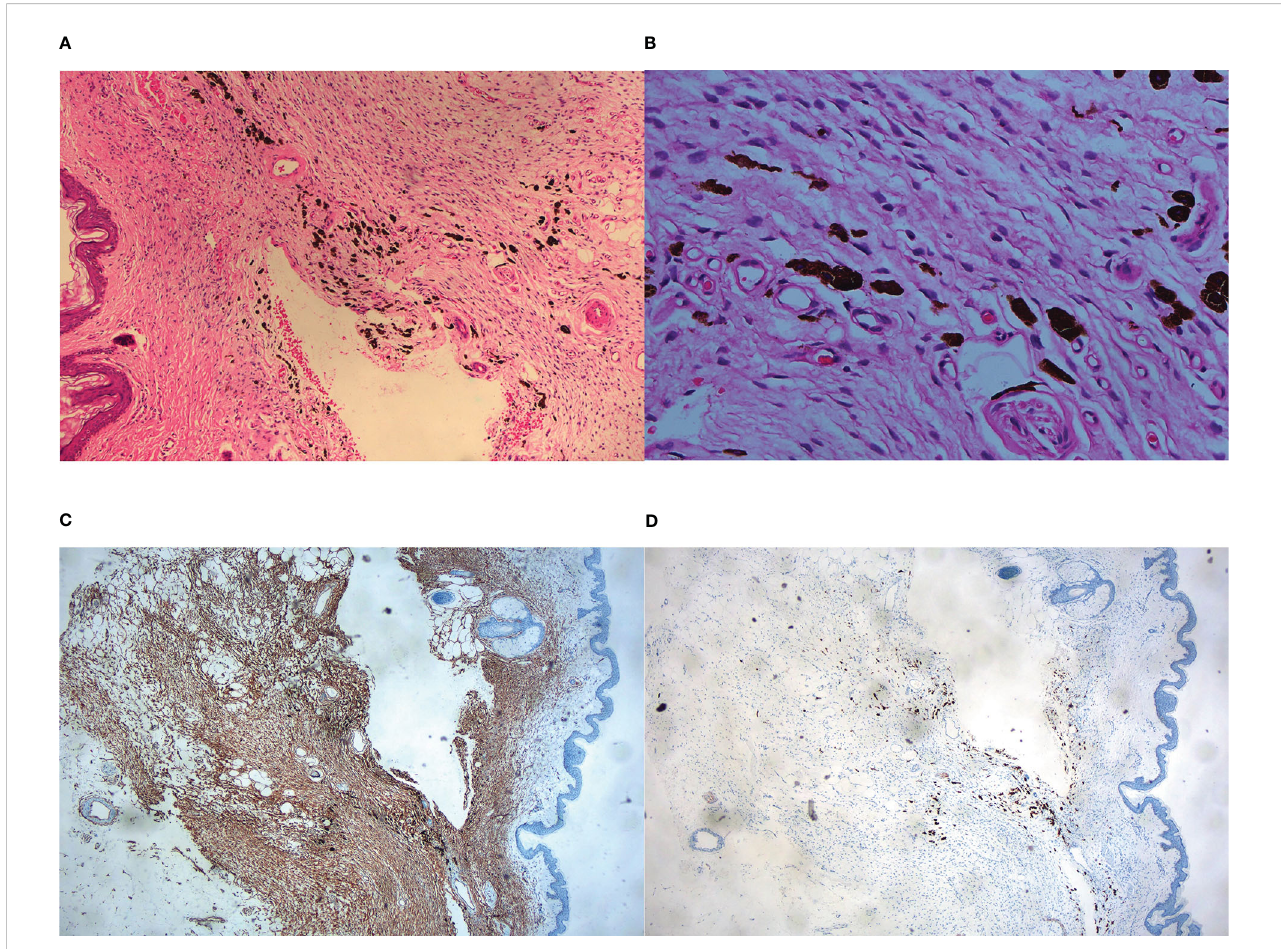
FIGURE 4 Histopathological examination. (A) Fascicles of spindle cells with reduced dermal thickness by about half on low-power view, HE ×40; (B) Monomorphic spindle cells with bland cytoplasm and scattered dendritic cells containing abundant melanin, HE ×200; (C) Immunohistochemistry showed CD34 + cells in fi ltrating into subcutis and forming honeycomb-like pattern, ×40; (D) Immunohistochemistry showed spindle cells were negative for S-100, in contrast, melanin-bearing dendritic cells were positive for S-100,